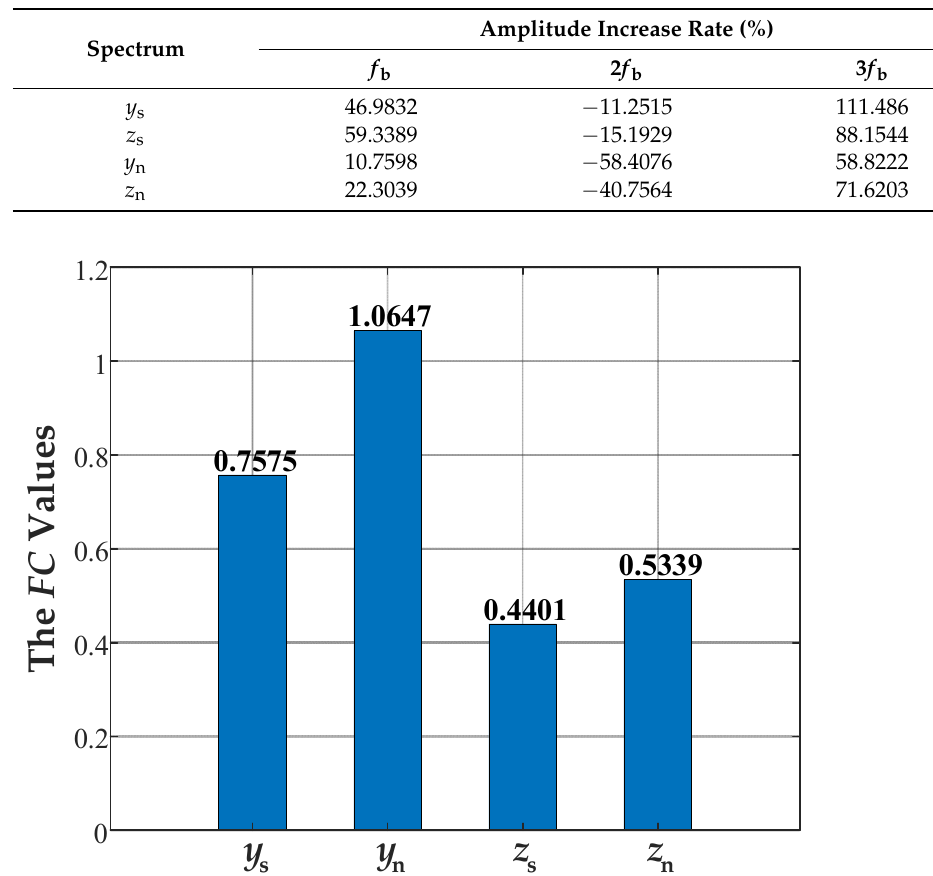
Figure 19. Experimental FC values of four parameters.